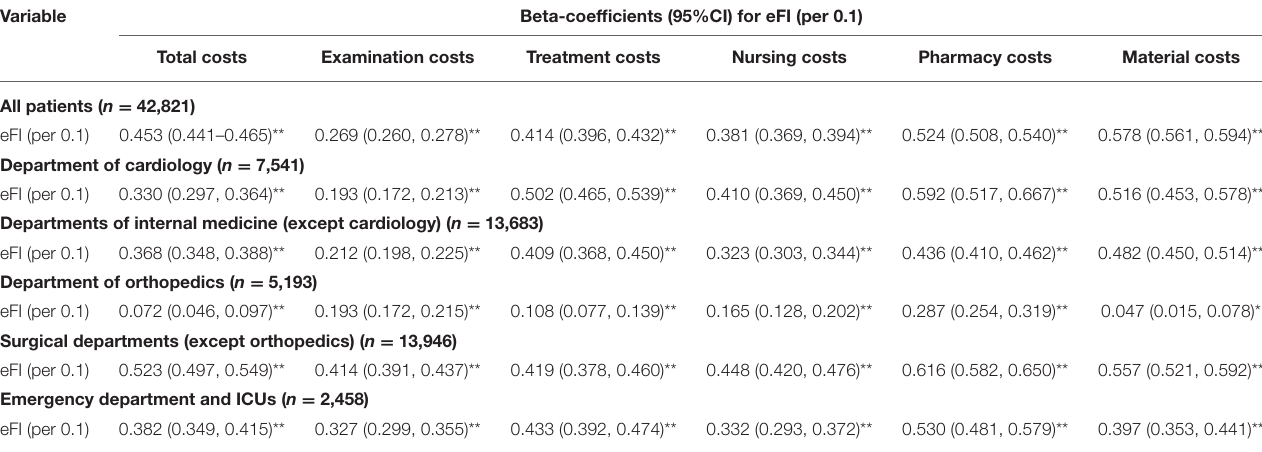
TABLE 4 | Association between eFI and hospitalized costs of elderly inpatients by generalized liner regression models.